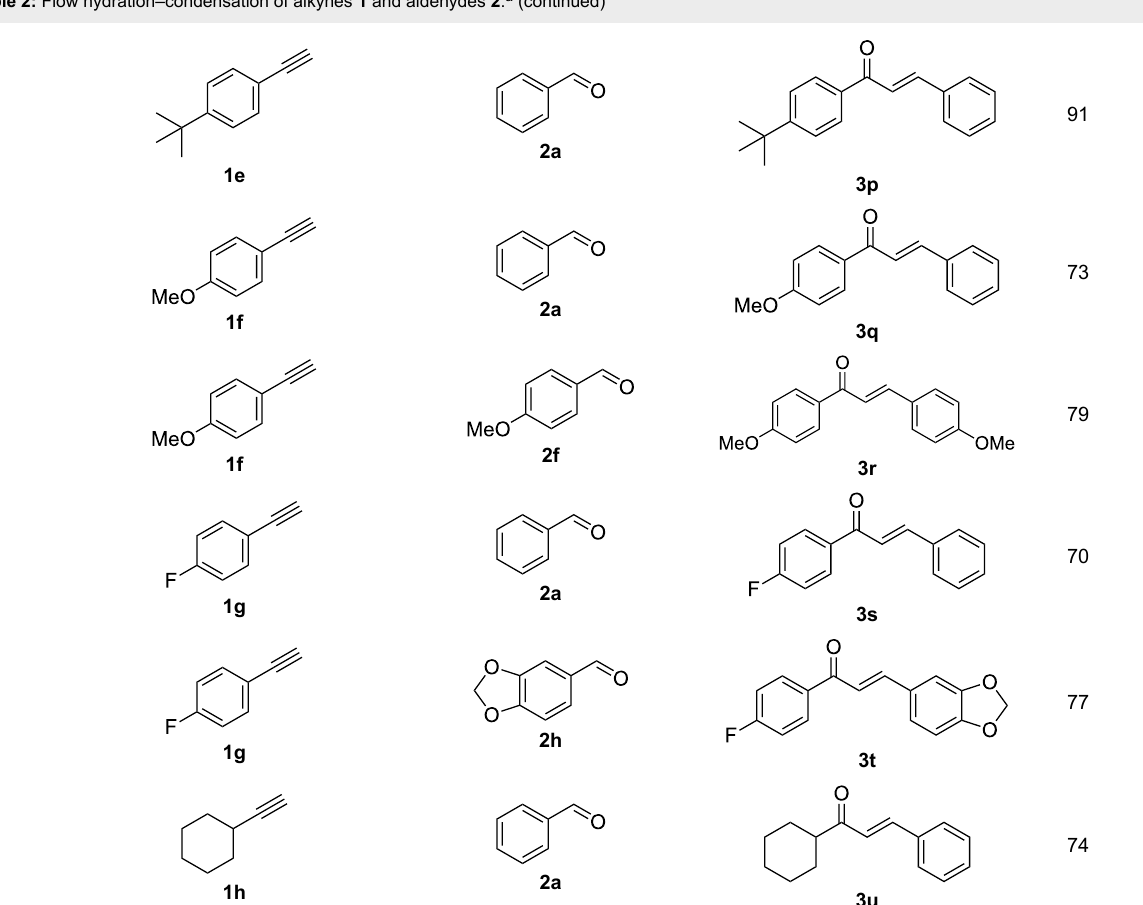
Table 2: Flow hydration–condensation of alkynes 1 and aldehydes 2 . a (continued)